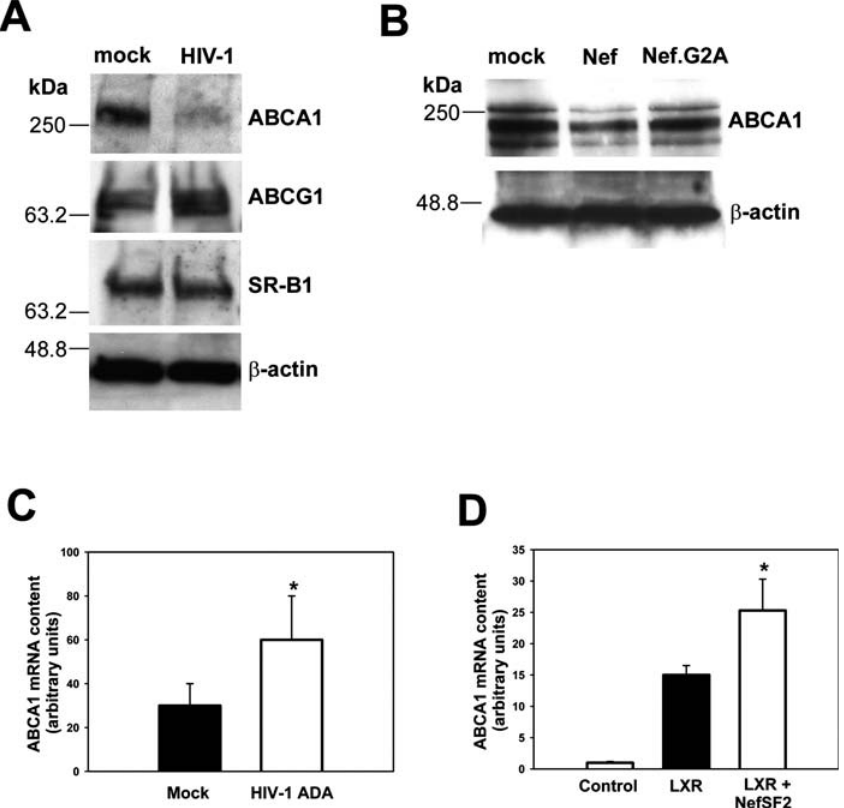
Figure 3. Nef Induces Down-Modulation of ABCA1 (A) Human monocyte-derived macrophages were infected with HIV-1 ADA or mock-infected and cultured for 14 d (RT in culture supernatant was 4,000 cpm/ l l). ABCA1, ABCG1, SR-B1, and b -actin (loading control) were analyzed by Western